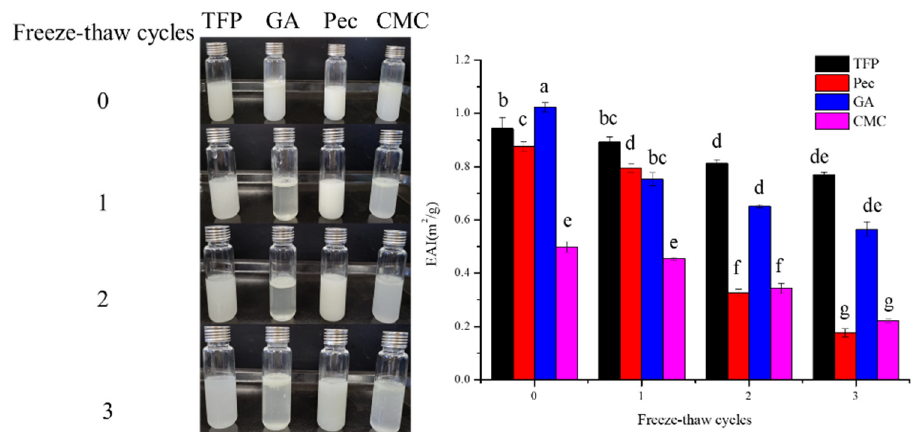
Figure 5. Effect of freeze-thaw treatment on the stability of different emulsions (Different letters indicate significant difference at p < 0.05). Table 1. Effect of freeze-thaw treatment on the particle size of different